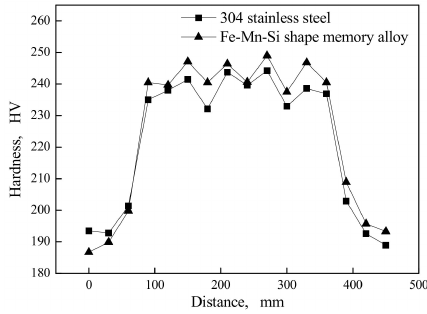
Figure 14. Microhardness distribution of welding